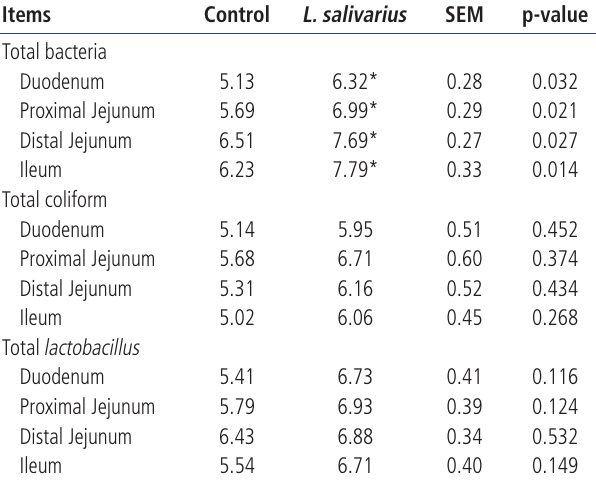
Table 6. Effect of Lactobacillus salivarius on intestinal bacterial population of piglets challenged with Escherichia coli F4 (Log10 cfu/mL) Items